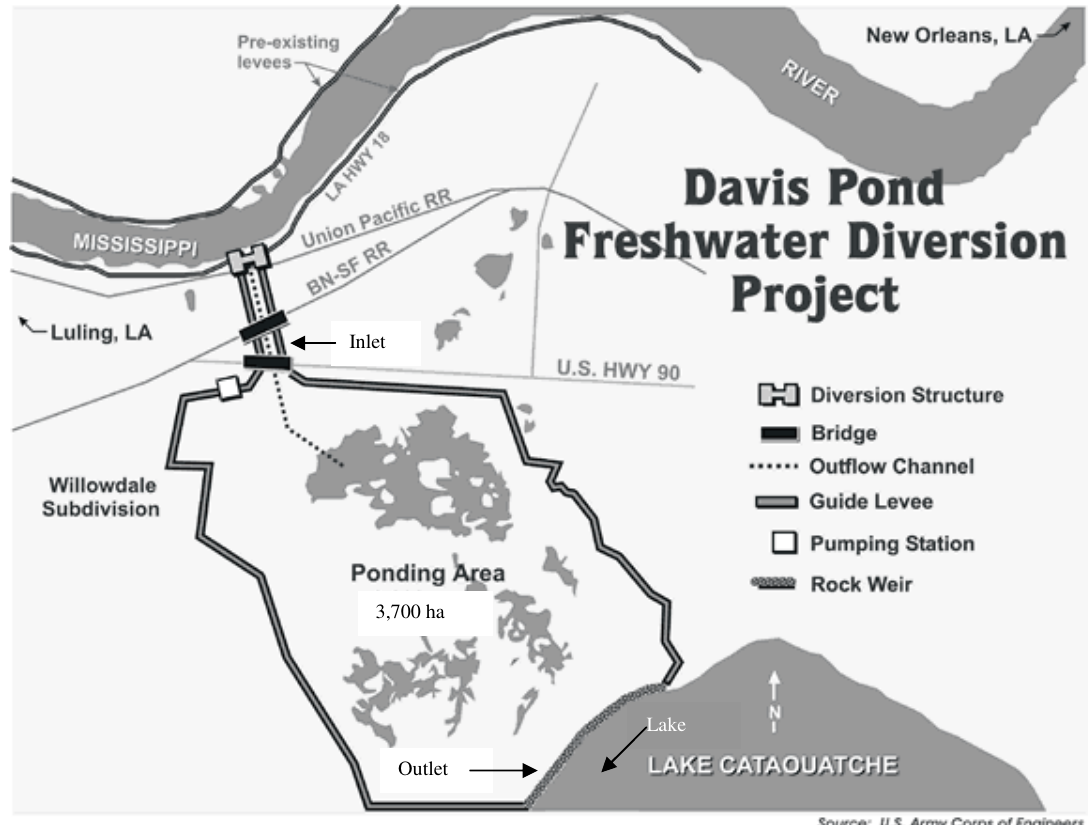
FIGURE 1. Sampling sites (inlet: 29 o 55'1.5''N, 90 o 19'3.1'' W; outlet: 29 o 51'40.5''N, 90 o 14'2.5'' W; lake: 29 o 51'10.5'' N, 90 o 13'13.8'' W). Adapted from